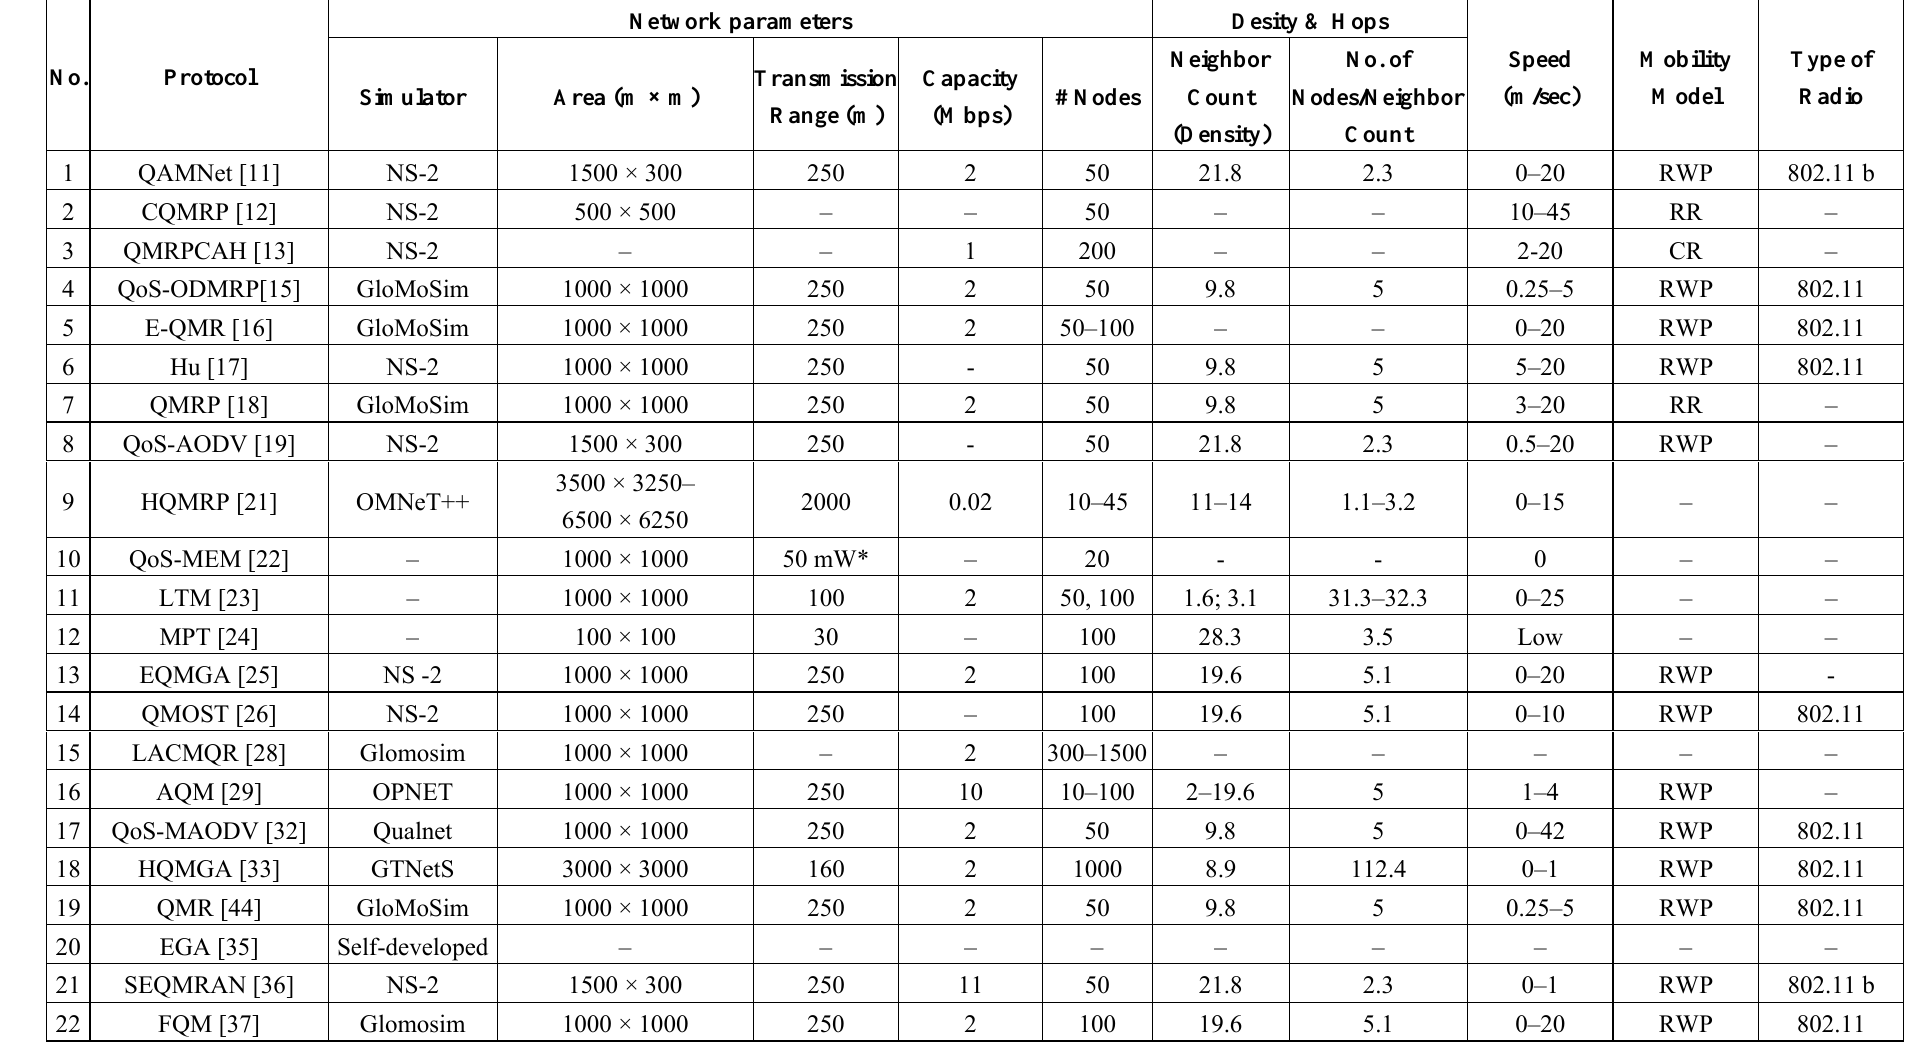
Table 3. Simulation parameters of evaluated scenarios